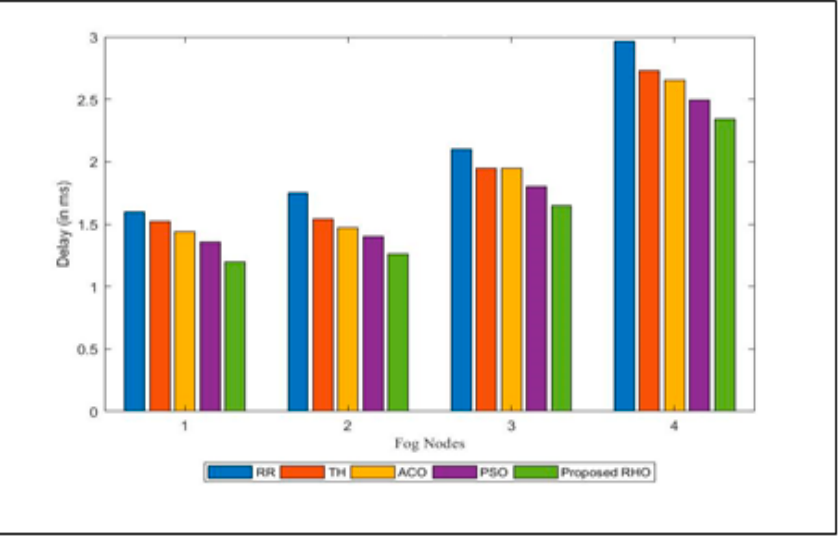
Figure 11. Delay for different algorithms for different Fogs Nodes.